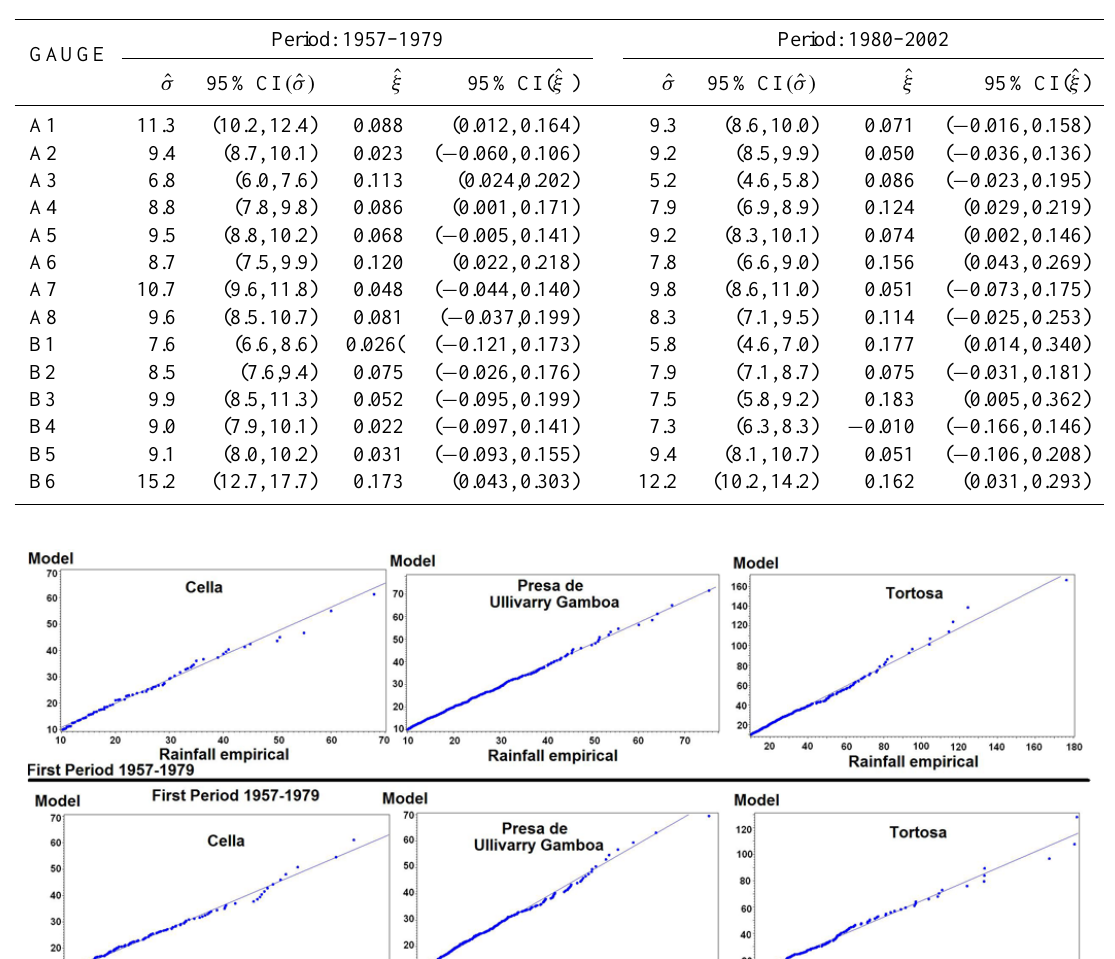
Table 4. GPD estimated parameters ˆ σ and ˆ ξ (optimum scale and shape parameters respectively) for each period with threshold=10. Confi- dence intervals are based on the delta method.